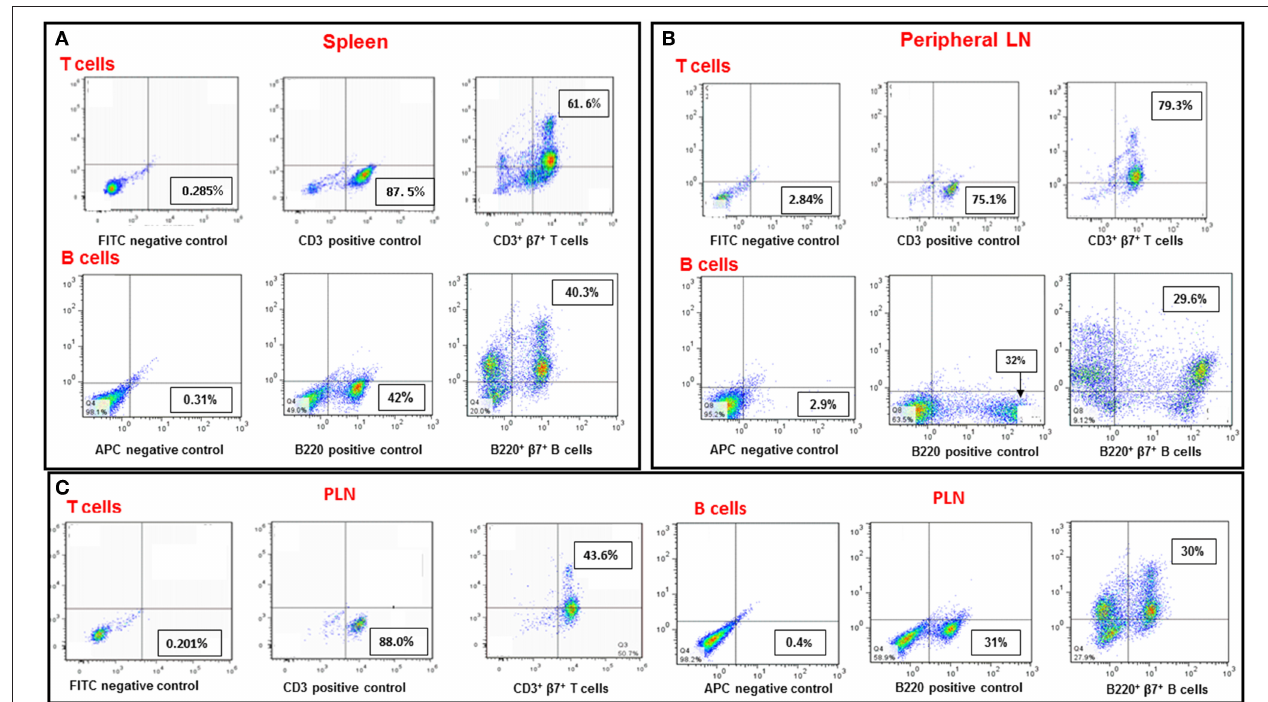
FIGURE 1 | Expression of the β 7 integrin subunit on T and B cells in various organs of NOD mice. Single cell suspensions from spleens (A) , peripheral LN (B) , and PLN (C) from 8-week-old NOD mice were stained with FITC-conjugated anti CD3, PE-conjugated anti β 7 and APC-conjugated anti B220. CD3 + β 7 + positive cells represent T cells expressing the β 7 integrin subunit. B220 + β 7 + positive cells represent B cells expressing the β 7 integrin subunit. The results represent one experiment representative of three